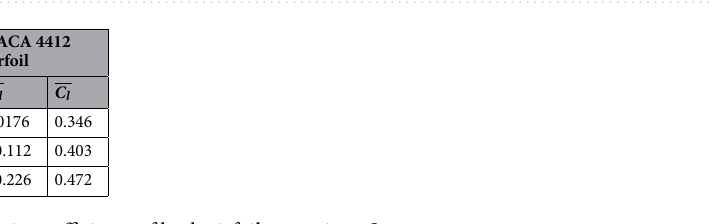
Table 5. The mean aerodynamic coefficients of both airfoils at various St